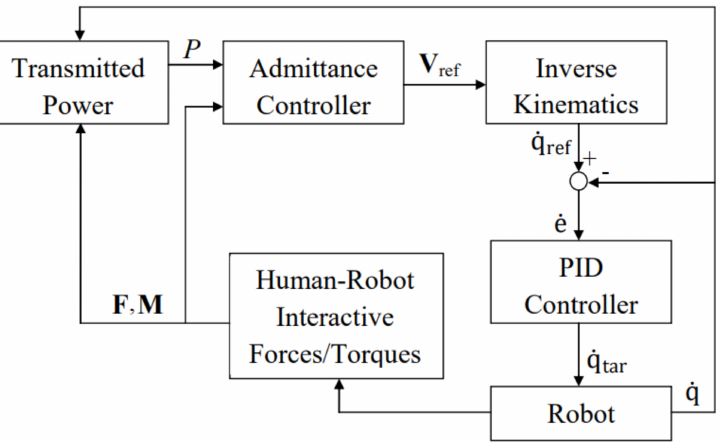
Figure 9. System framework, admittance controller block represents MLP-HA-based admittance controller, Bi-HA-based admittance controller, or fuzzy-based admittance controller depending on the